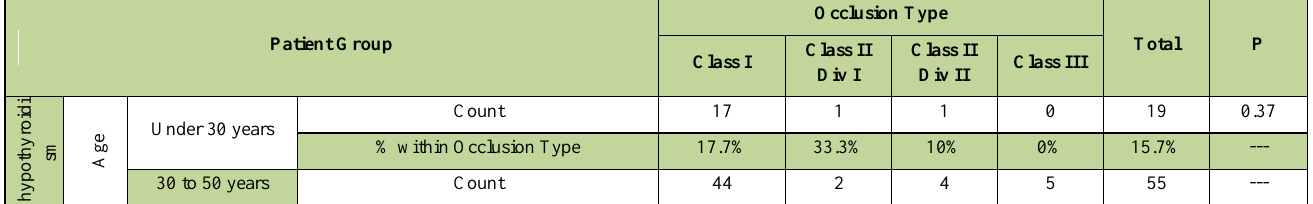
Table 9. Malocclusion in two groups of patients by